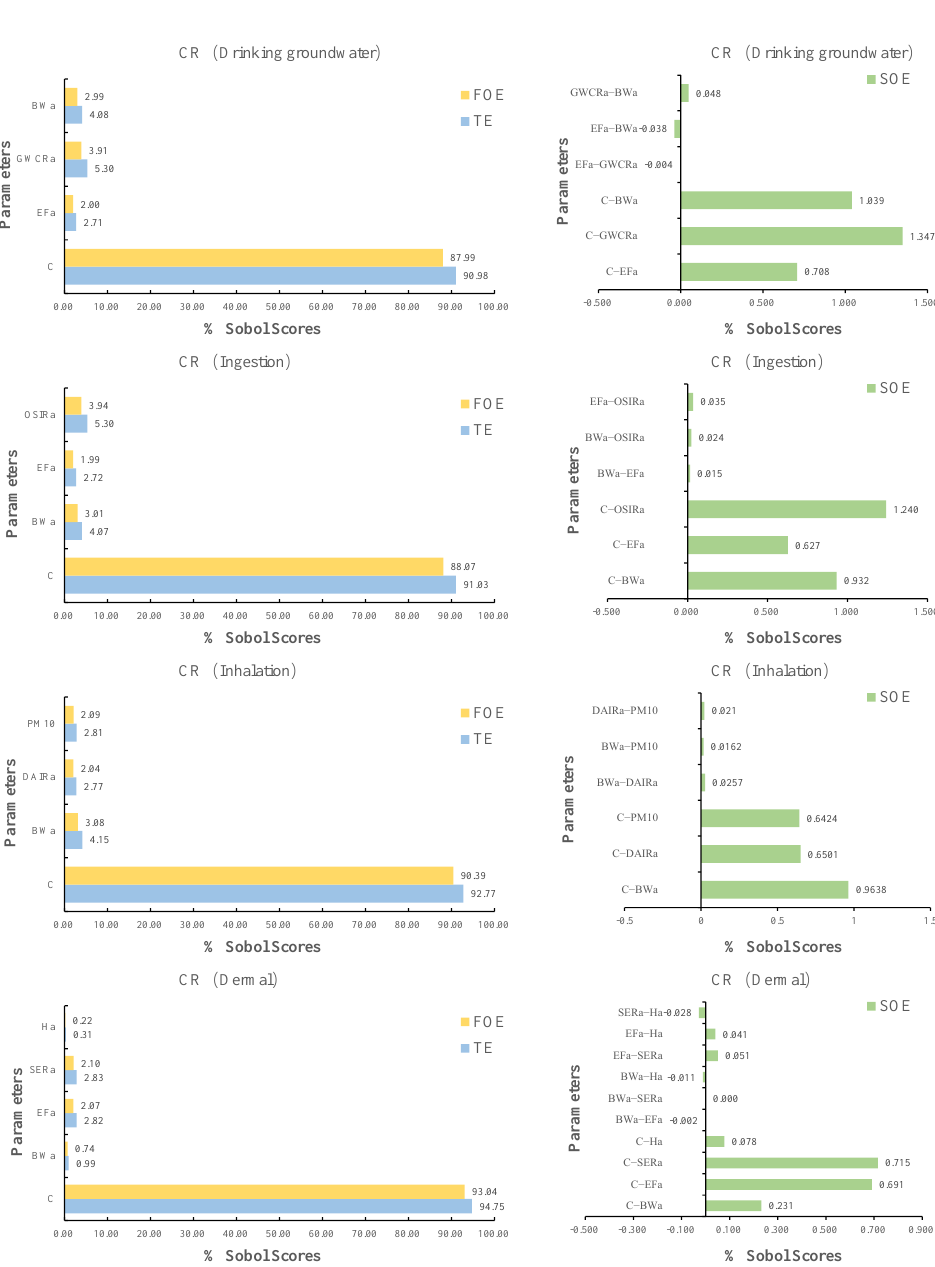
Figure 4. Sensitivity analysis based on CR models for different exposure routes, considering first- order effects (FOE), second-order effects (SOE) and total effects (TE).